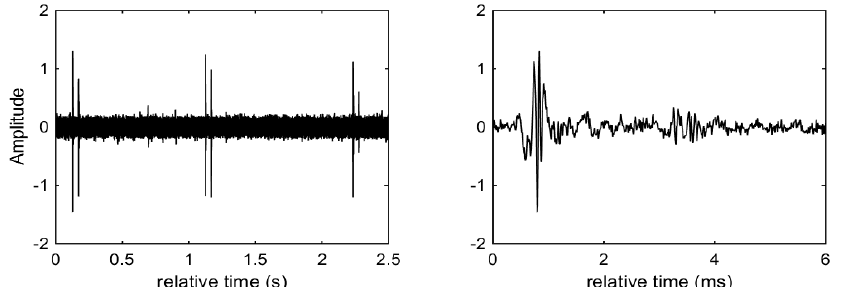
Figure 12. Extract from a sequence of regular clicks ( left ) and detailed view of a single click ( right ) recorded off Palaiochora.